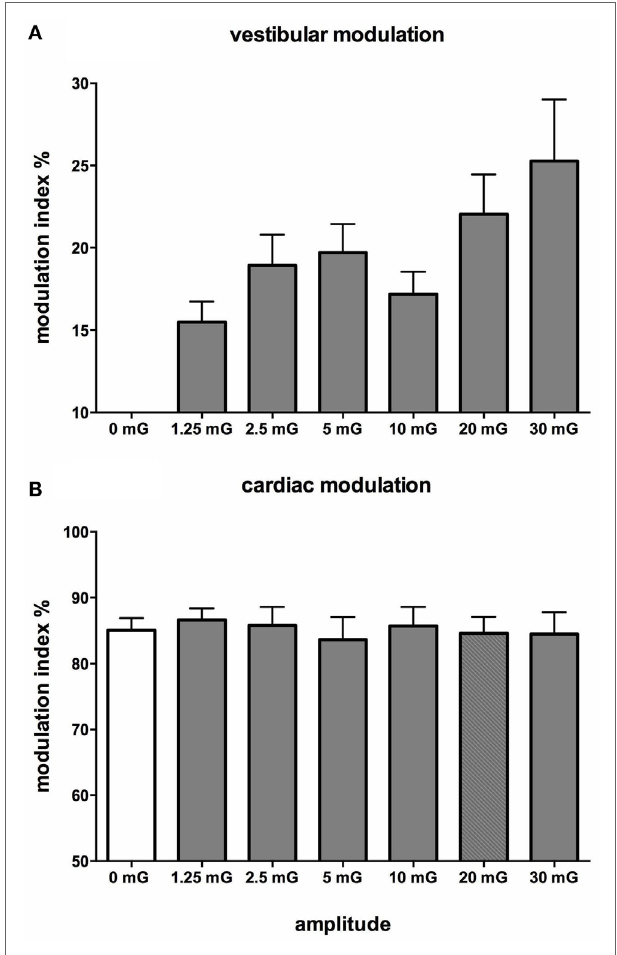
FiGURe 10 | Mean vestibular (A) and cardiac (B) modulation indices of muscle sympathetic nerve activity as a function of acceleration amplitude; 0 mG = static condition (vestibular modulation = 0 in the absence of a sinusoidal vestibular input). Mean ± SE data from 13 subjects. Reproduced with permission from Hammam et al. (74).